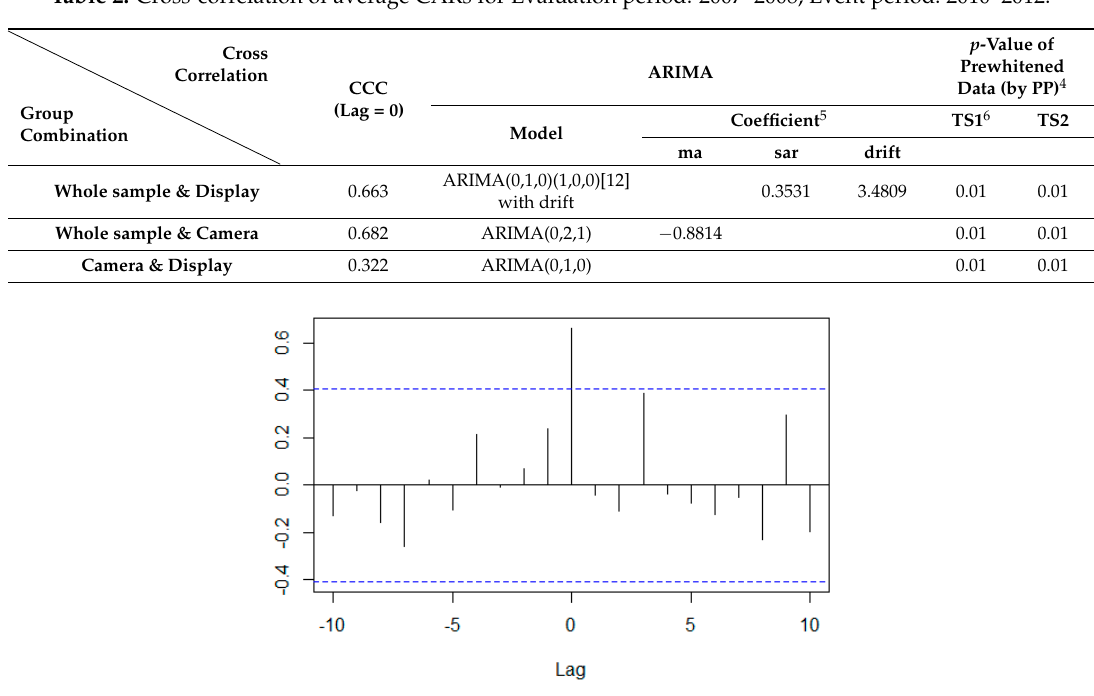
Figure 2. Cross-correlation coefficient between the average CAR of the whole sample group and the average CAR of the display group for Evaluation period: 2007–2008, Event period: 2010–2012 7